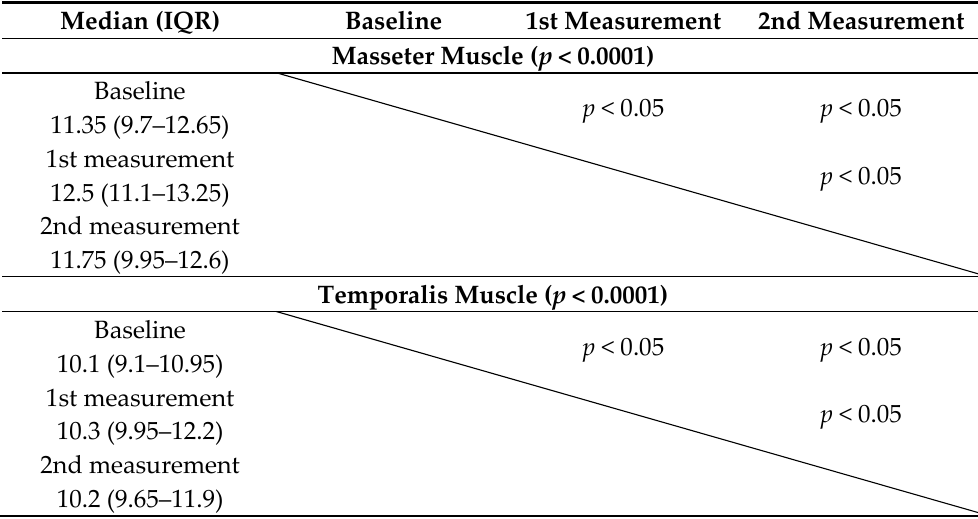
Table 2. Comparison of stiffness measurements as measured with shear wave elastography between the masseter muscle and temporalis muscle.